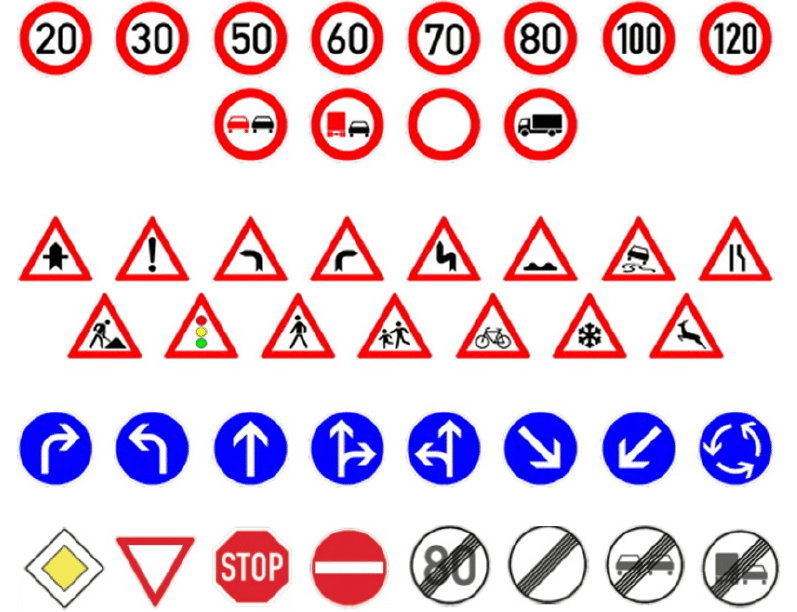
Figure 2. German traffic sign recognition benchmark (GTSRB) dataset.